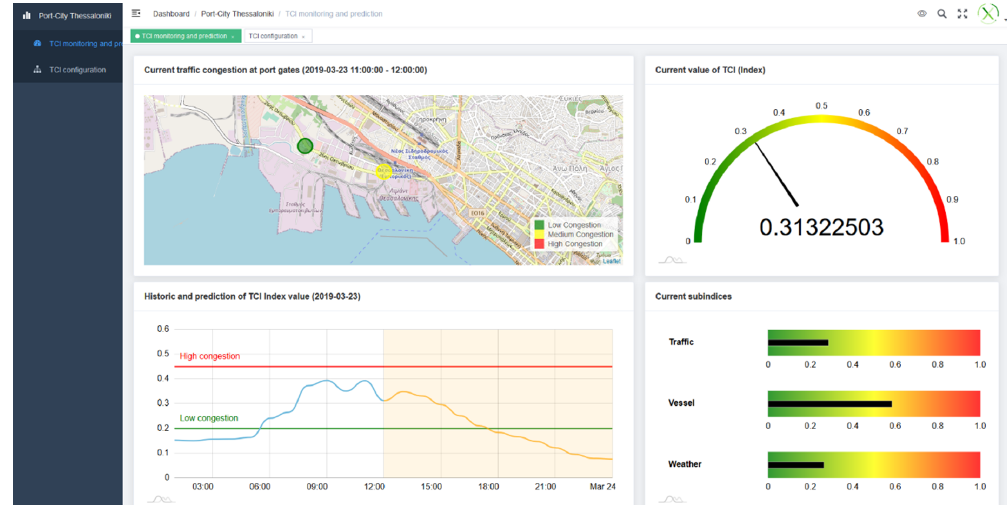
Figure A5. Visualization of the scenario 1.2 in the UI dashboard.